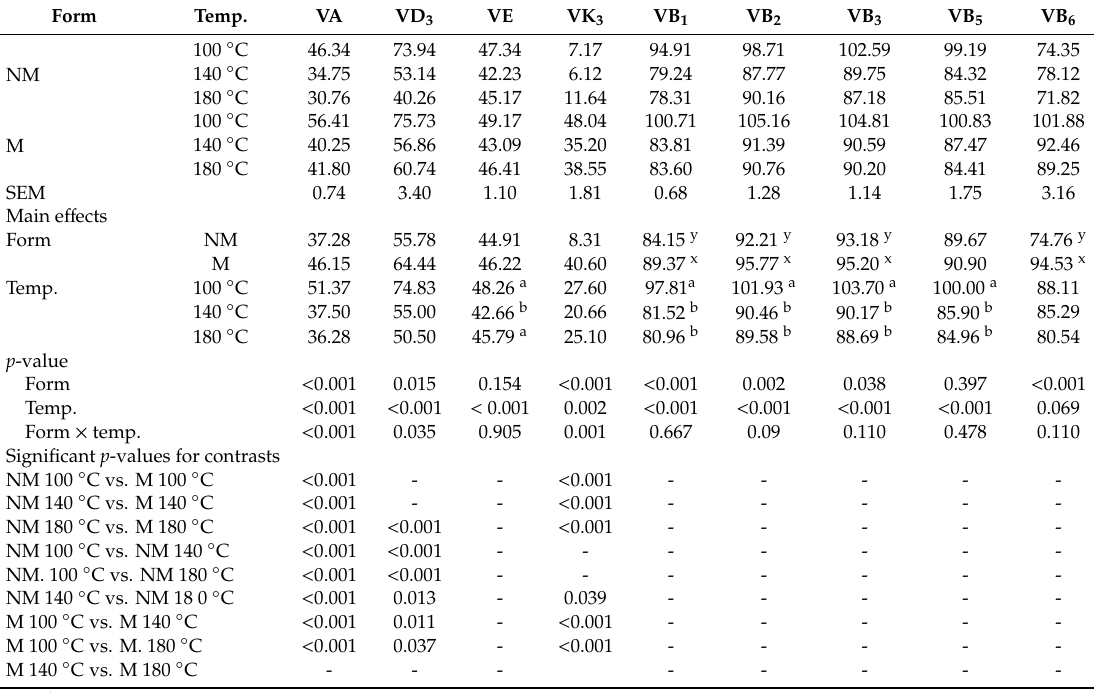
Table 5. E ff ects of extruded temperature (Temp.) and vitamin forms (non-microencapsulated or microencapsulated) on the percentage of vitamins in diets (Experiment 1) 1